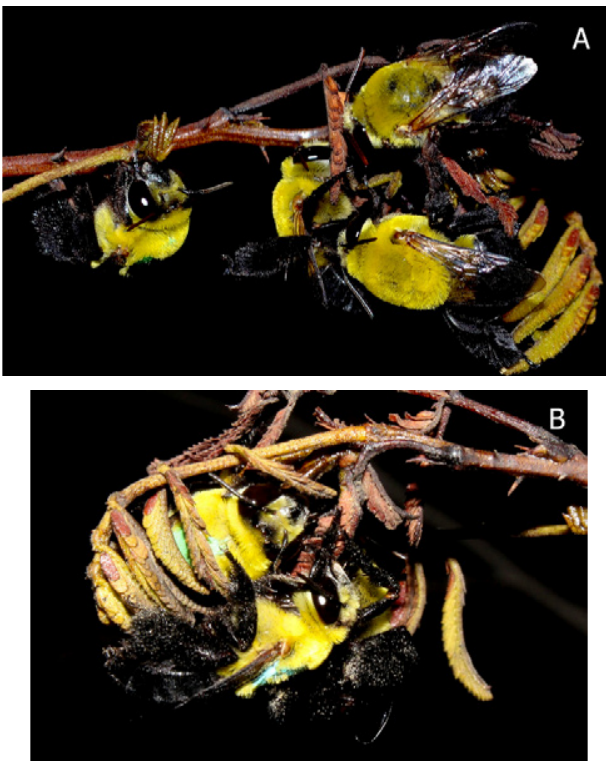
Fig 1 . Main composition of sleeping aggregation on branches of Mimosa tenuiflora in an Caatinga area, Petrolina, Brazil, July 2017. (a) Female and males sharing the same branches as dormitory, (b) sleeping aggregation composed only by